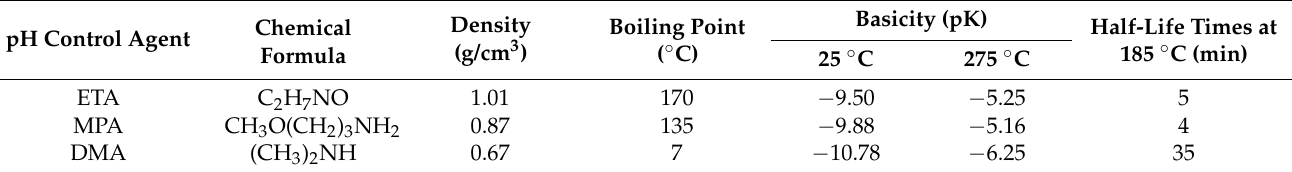
Table 1. Basic properties of three advanced amines widely used for control of secondary water chemistry in PWRs. pH Control